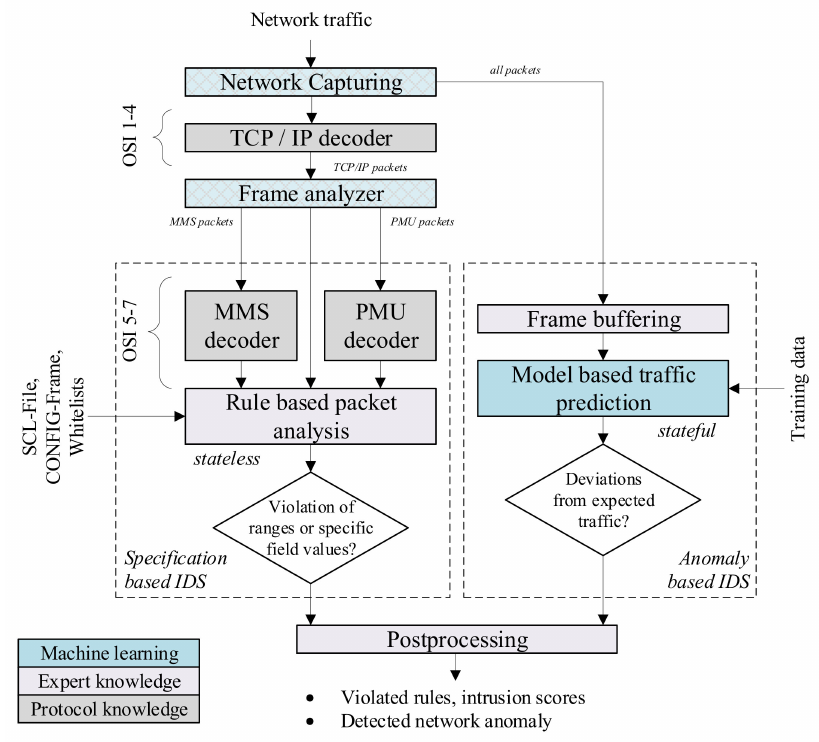
Figure 3. Basic architecture and workflow of the hybrid NIDS